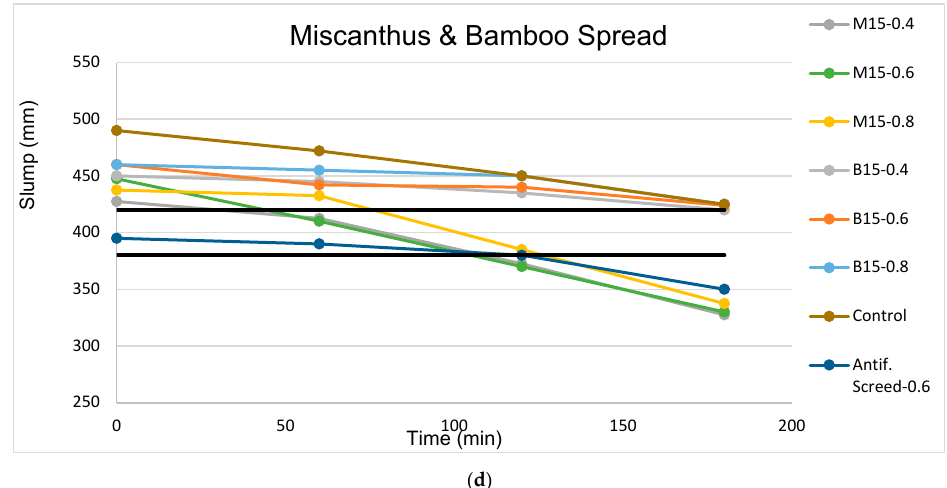
Figure 8. ( a ) Slump versus time for soft 5 mm fibers ( b ) Slump versus time for soft 15 mm fibers ( c ) Slump versus time for rigid 5 mm fibers ( d ) Slump versus time for rigid 15 mm fibers.